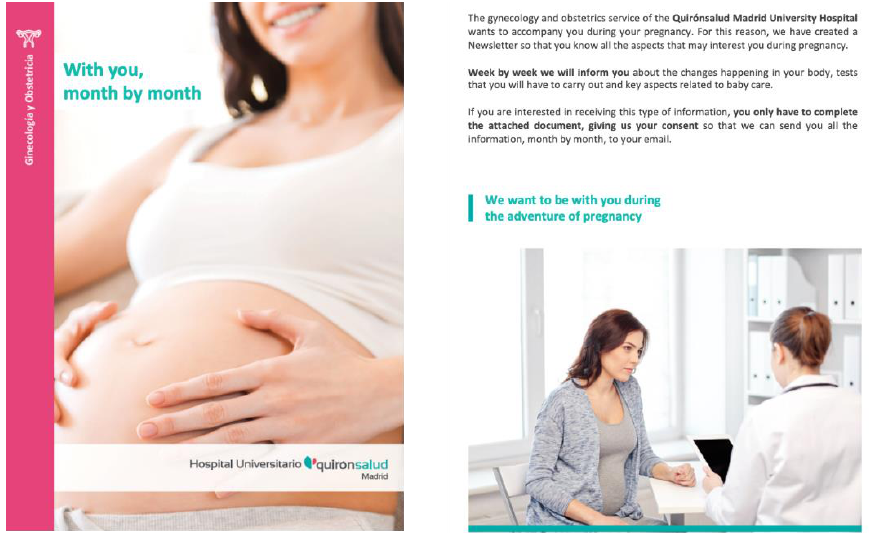
Figure A1. Flyer informing about the digital Newsletter ‘Contigo mes a mes’ program (prepared internally and by the HUQSM marketing department).